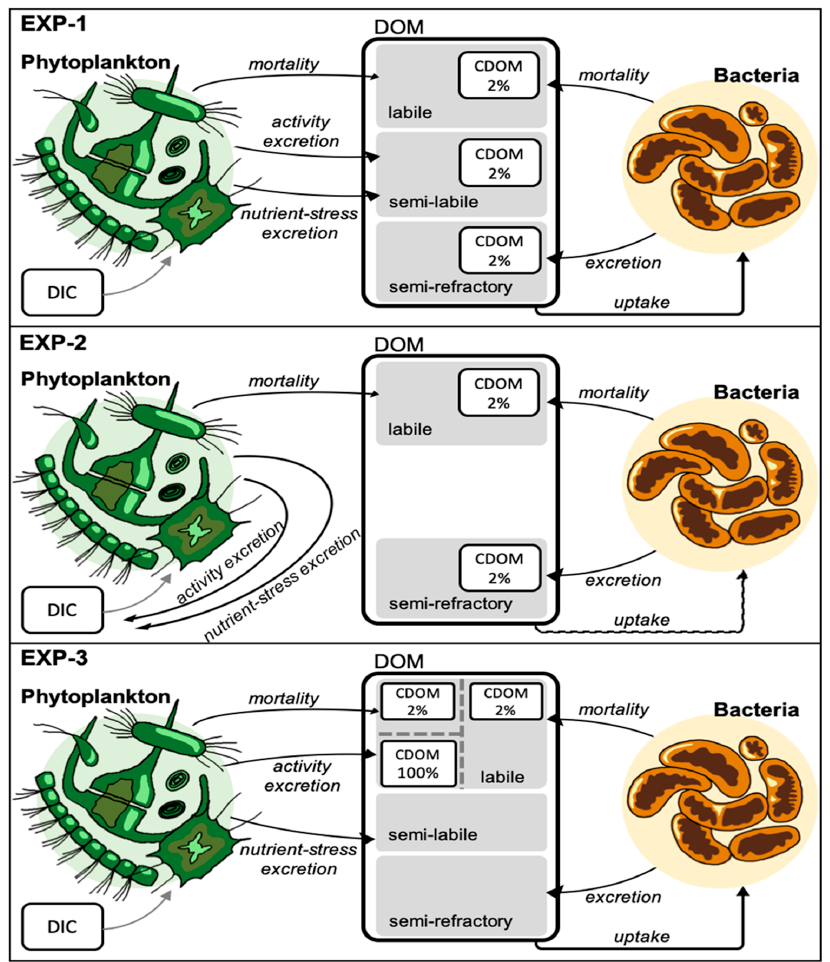
Figure 2. Conceptual models considered in the present study. Phytoplankton is partitioned in four separate phytoplankton functional types. In EXP-2 different dissolved organic matter (DOM) pools are simulated with different remineralization rates, according to heterotrophic bacteria metabolic rates. The wavy arrow in the EXP-2 scheme indicates the reduced uptake by bacteria of DOC.